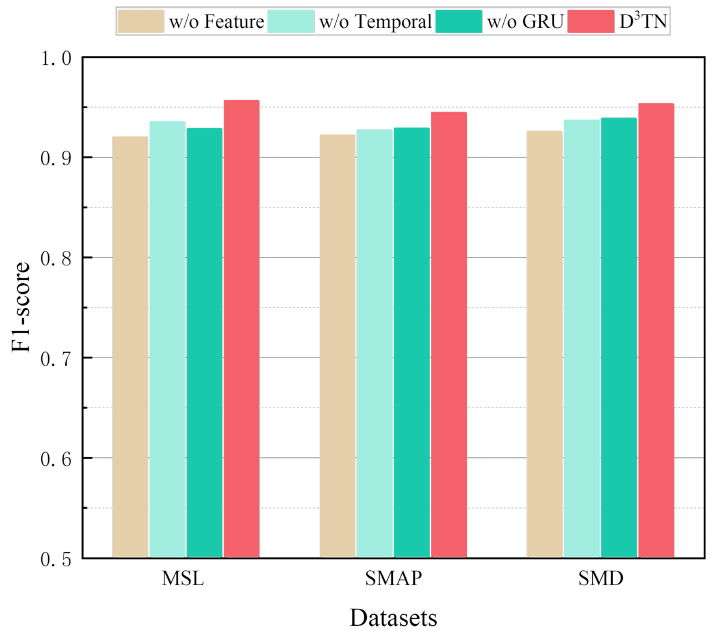
Figure 5. F1-score of our model and the